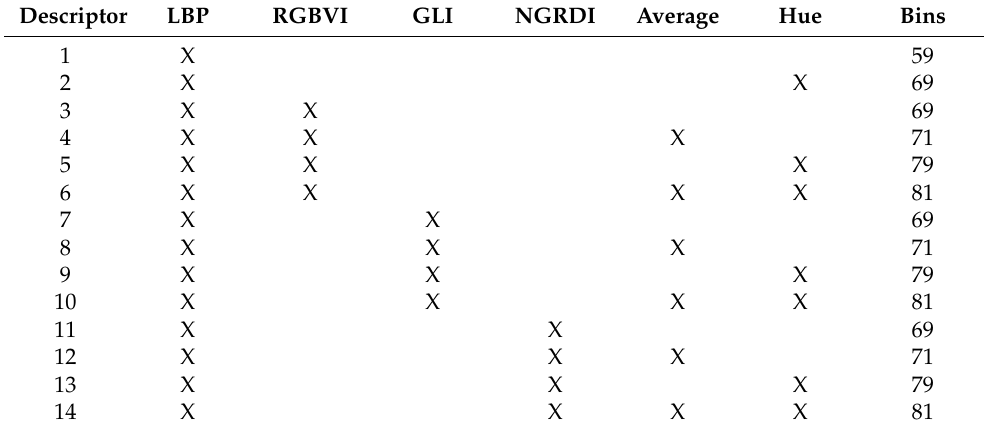
Table 2. Different descriptors identification according to the combination of the six concepts used. Descriptor